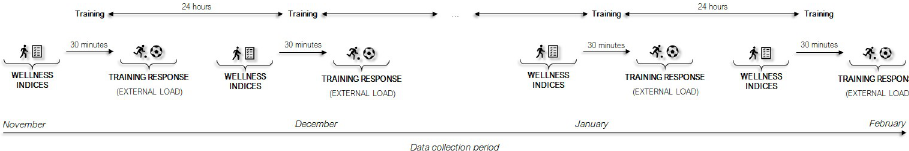
Fig 1. Representation of data collection period. The ellipsis represents the sequence of the training sessions throughout the 16-weeks of the in-season